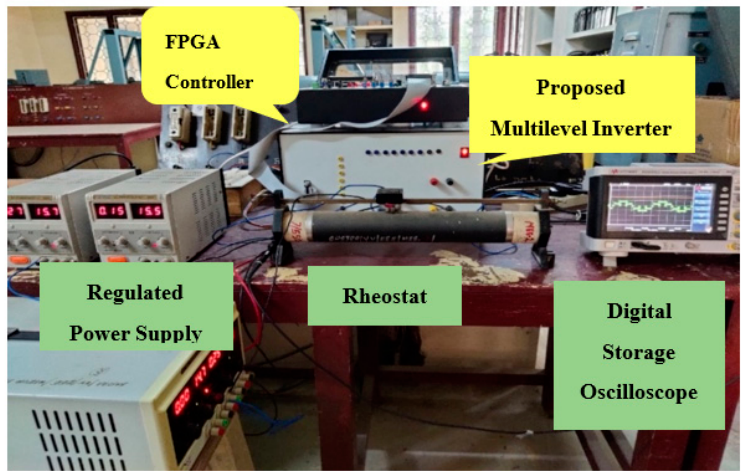
Figure 20. Hardware setup for proposed multilevel inverter.